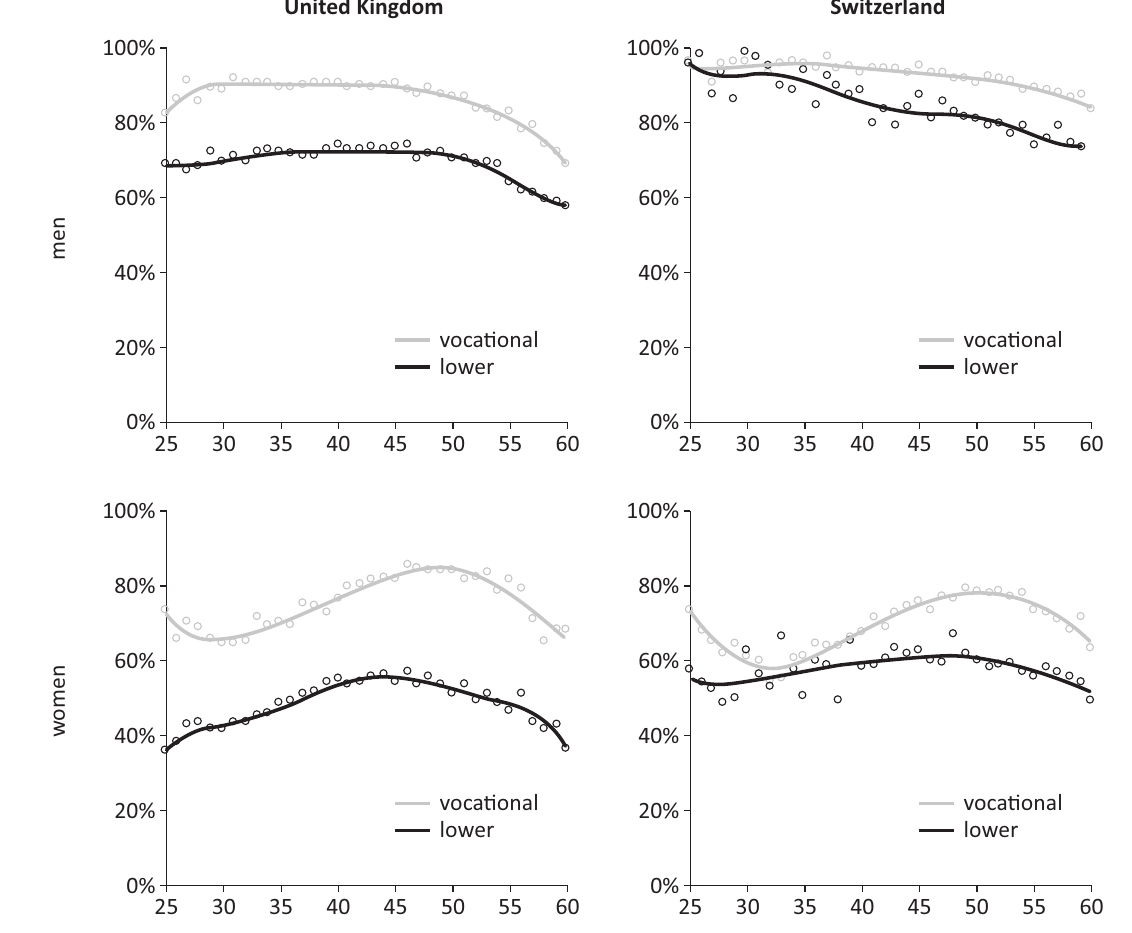
Figure 1. Employment rate (minimum 8 hours per week) for men and women by level of education and age: upper- secondary vocational education ( vocational ) and compulsory school or lower ( lower ). Source: UK Labour Force Survey 1993–2014 and Swiss Labour Force Survey 1991–2014, cohort 1954–1968. Note: Black and grey lines represent the poly- nomial trend line for the respective